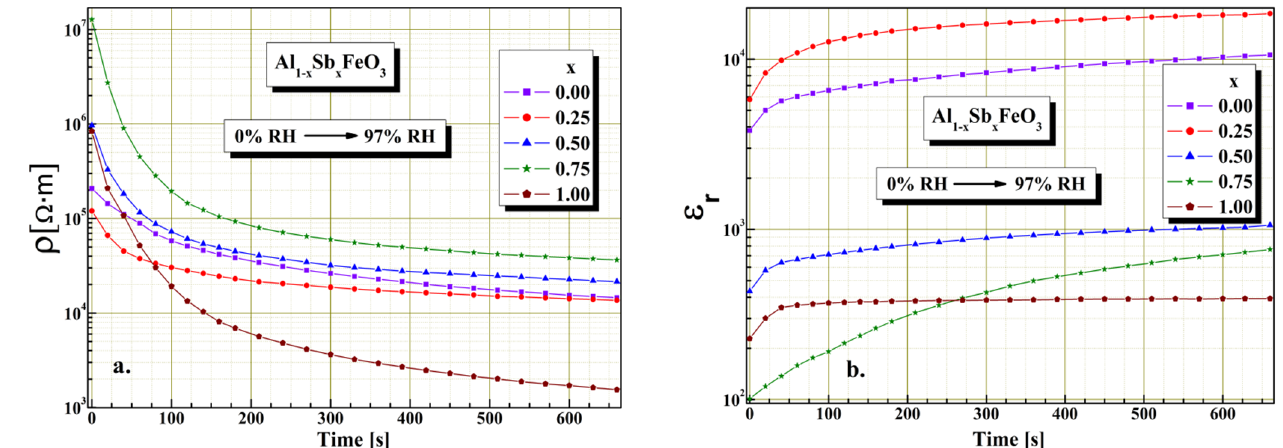
Figure 10. Response time for resistive sensor ( a ) and capacitive sensor ( b ) for Al 1-x Sb x FeO 3 perov- skites.